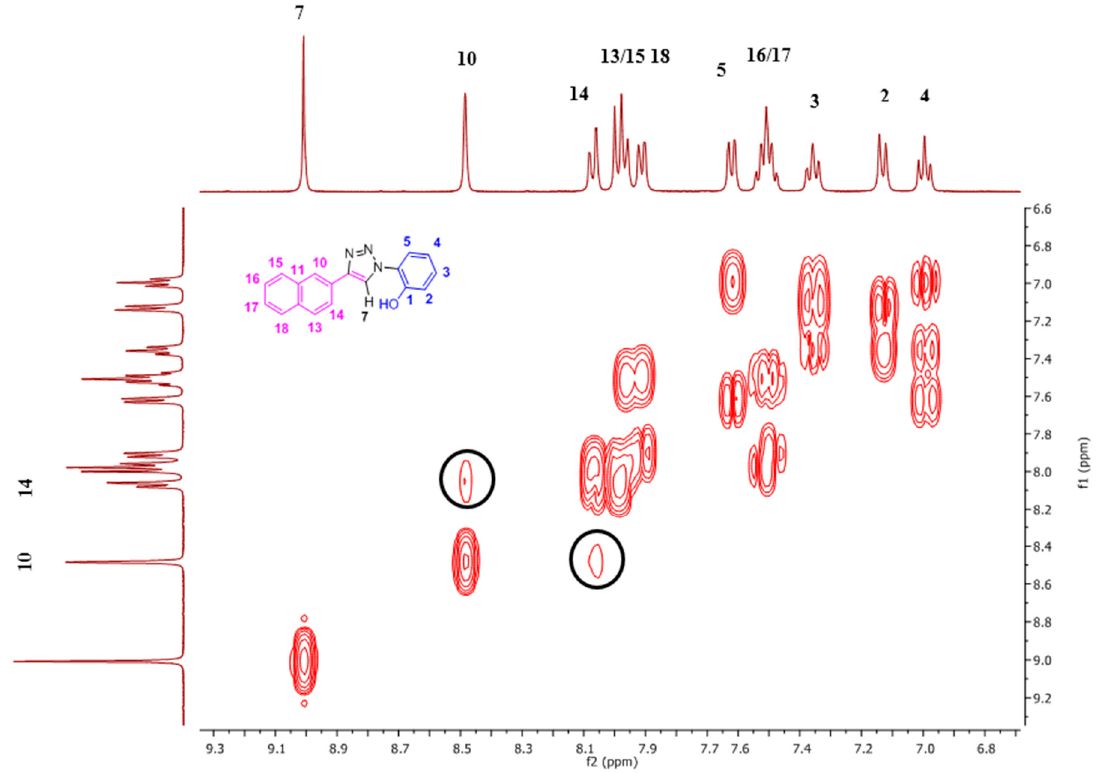
Figure 3. The 2D-COSY spectrum (400 MHz, (CD 3 ) 2 S=O, RT) of NpTP molecule, the correlation with all aromatic protons is seen.